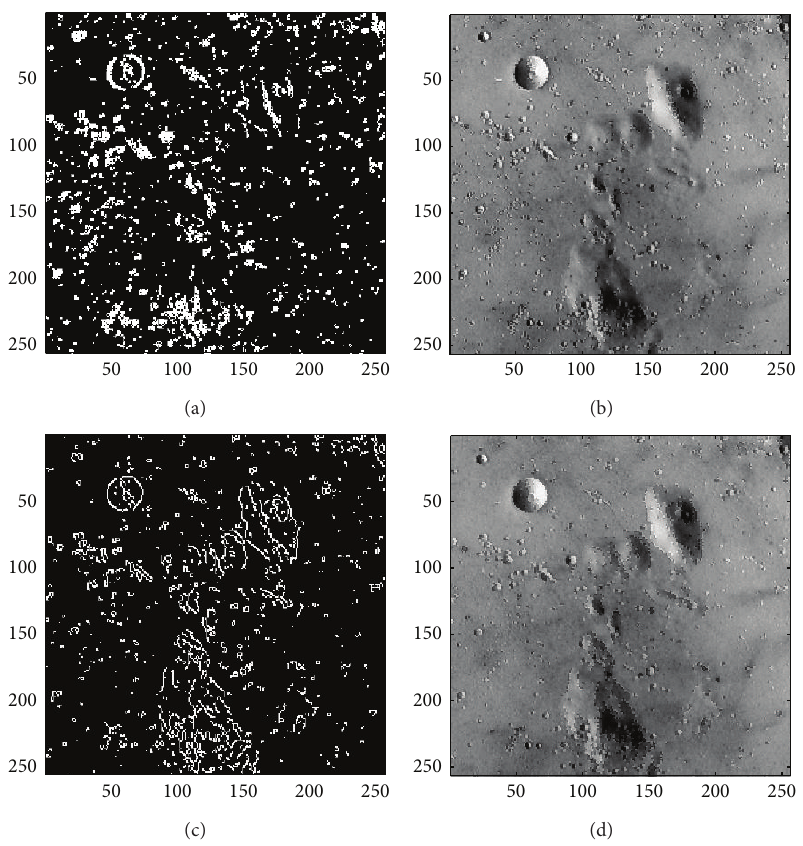
= 16 in the image “Moonsurface.” (b) Result by HVD with scaling factor 𝑠 = 1.0 . (c) Edges Figure 6: (a) Edges detected by HVD with 𝜃 eth detected by Canny operator in the image “Moonsurface.” (d) Result by Canny operator with scaling factor 𝑠 = 1.0 .